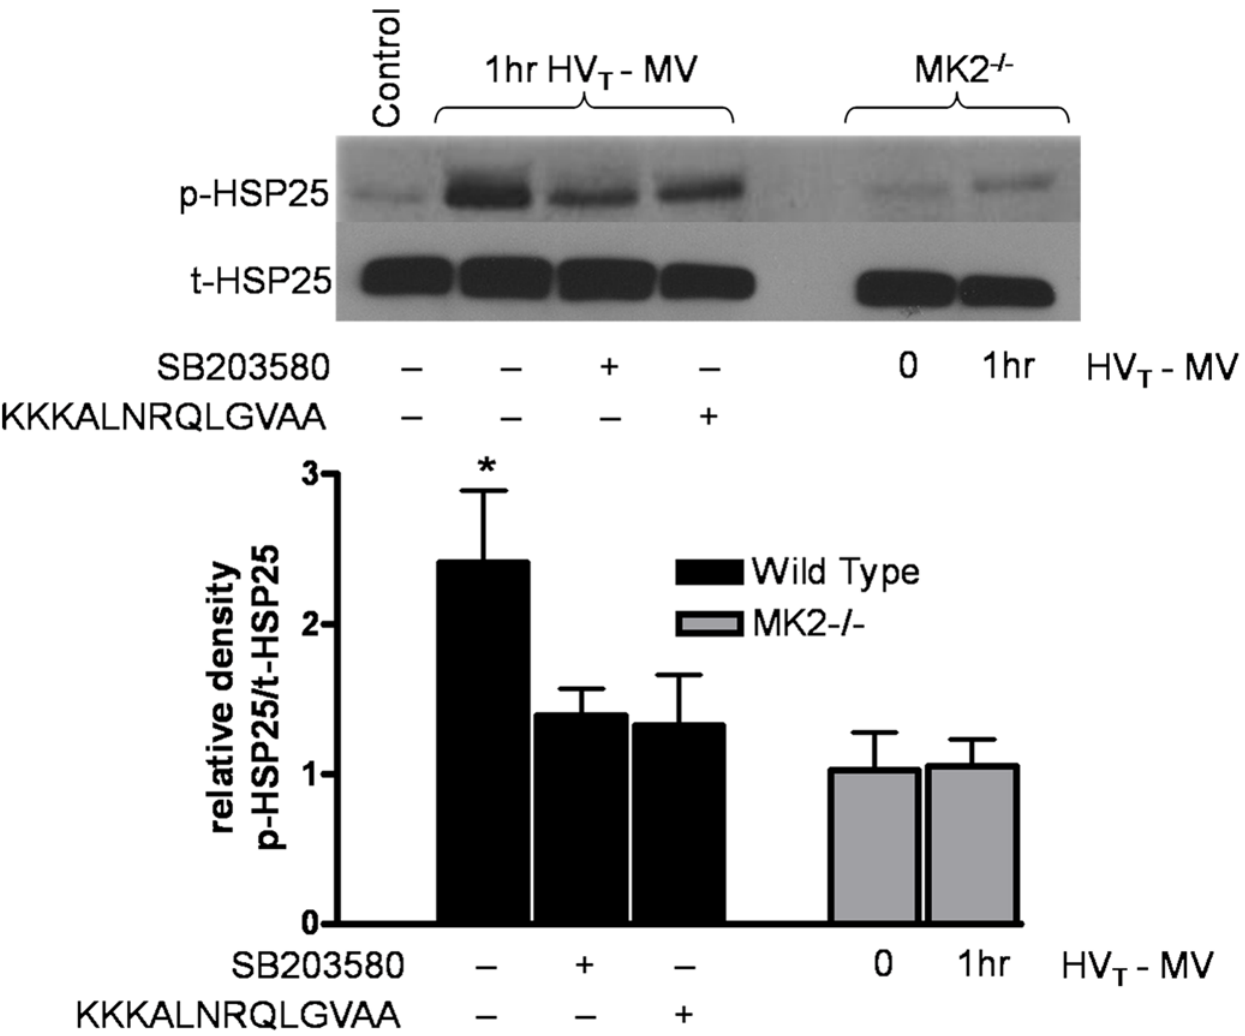
Figure 3. p38 MAP kinase and MK2 inhibition prevents phosphorylation of HSP25. Wild type or MK2 2 / 2 mice were exposed to MV at HV T for 0 or 60 minutes (peak of HSP25 phosphorylation), after which lungs were harvested for immunoblotting for phosphorylated HSP25. A subset of wild type mice were pretreated with the p38 MAP kinase inhibitor SB203580 or the MK2 inhibitor KKKALNRQLGVAA. A representative Western blot indicates that chemical inhibition of p38 MAP kinase or MK2 abrogates the phosphorylation of HSP25 and that MK2 2 / 2 mice fail to phosphorylate HSP25 after exposure to HV T MV. Densitometric analysis confirms that the ratio of phospho-HSP25/total-HSP25 peaks is significantly inhibited with inhibition of p38 MAP kinase and MK2 after 60 min of HV T MV. * P , 0.05 (vehicle vs wild type counter parts). N=3–4 mice per